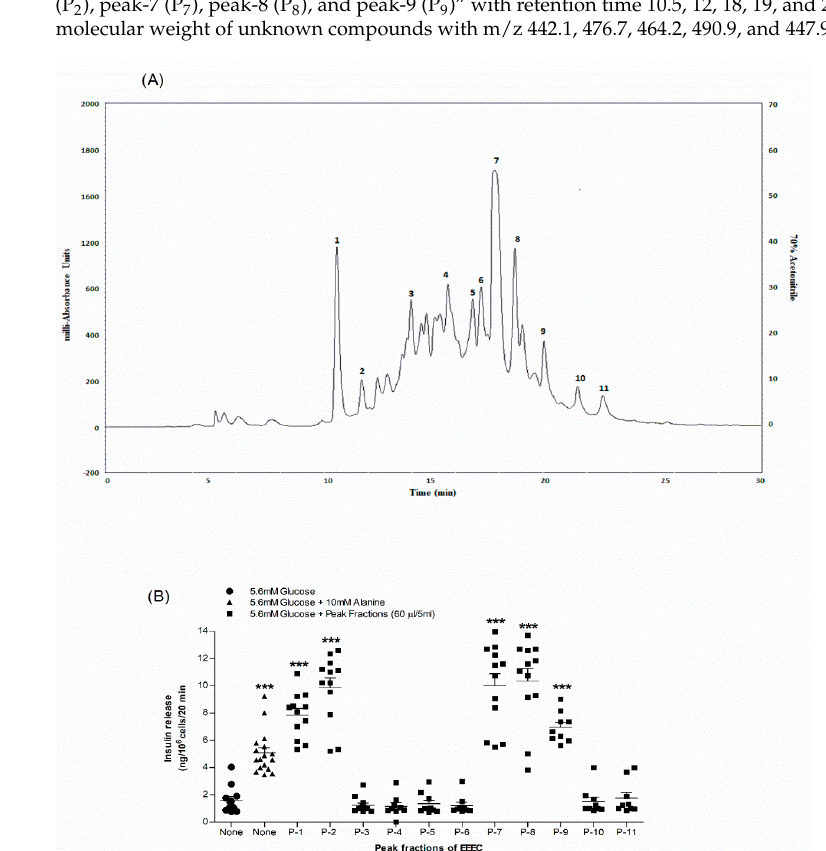
Figure 5. Representative ( A ) HPLC profile and ( B ) insulin-releasing effects of peak fractions (1,2,7-9) of EEEC. Crude extract was chromatographed at a flow rate of 1.0 mL/min on a (10 × 250 mm) semi-preparative 5 µm C-18 column (Phenomenex, UK). Using linear gradients of acetonitrile (0–20% up to 10 min, 20–70% up to 40 min), the concentration of the eluting solvent was increased. Compounds were detected by measurement of absorbance at 254 nm. Peak fractions 1, 2 and 7–9 were collected and insulin-releasing activity assessed using BRIN-BD11 cells. Values n = 8 for insulin release are mean ± SEM. *** p < 0.001 compared to control.